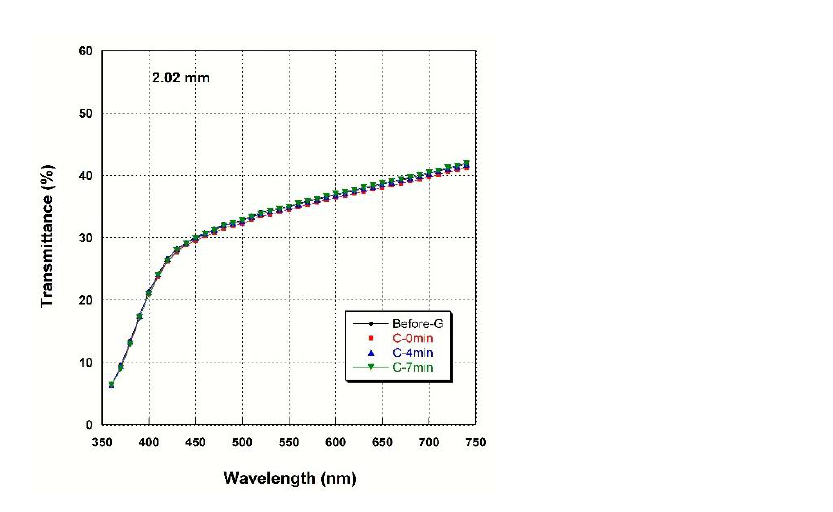
Figure 4. Spectral transmittance curves for various cooling rates at a thickness of 1.53 mm.